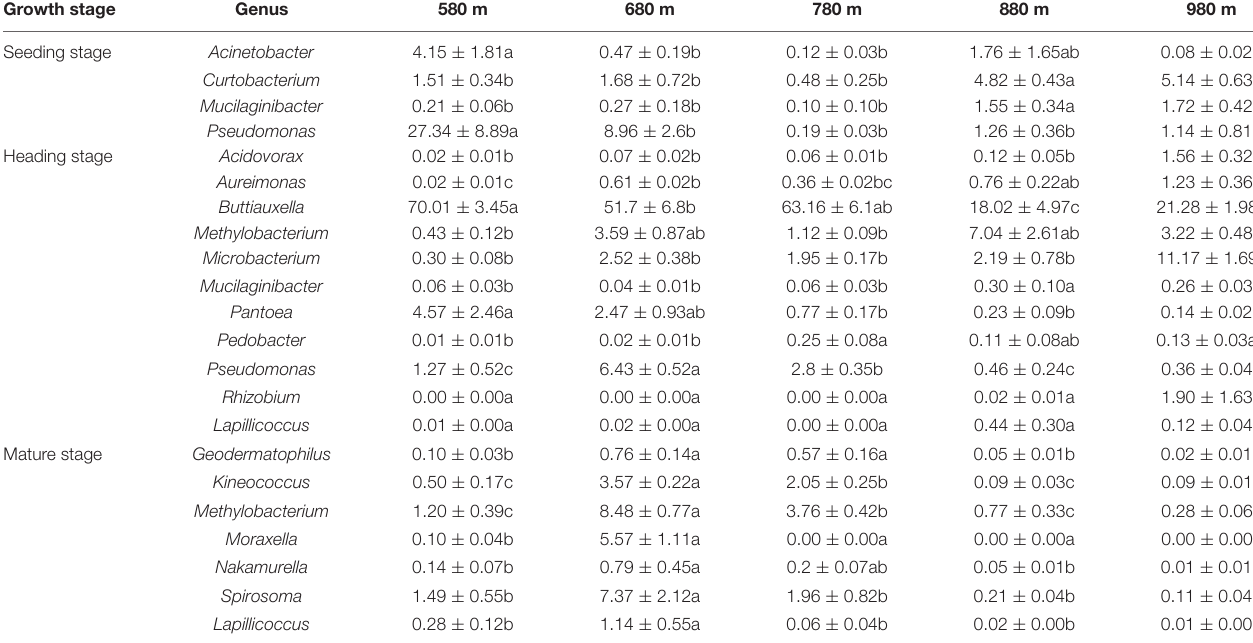
TABLE 2 | The relative abundance of genera was significantly correlated with elevation among the top 30 phyllosphere bacterial genera. Growth stage